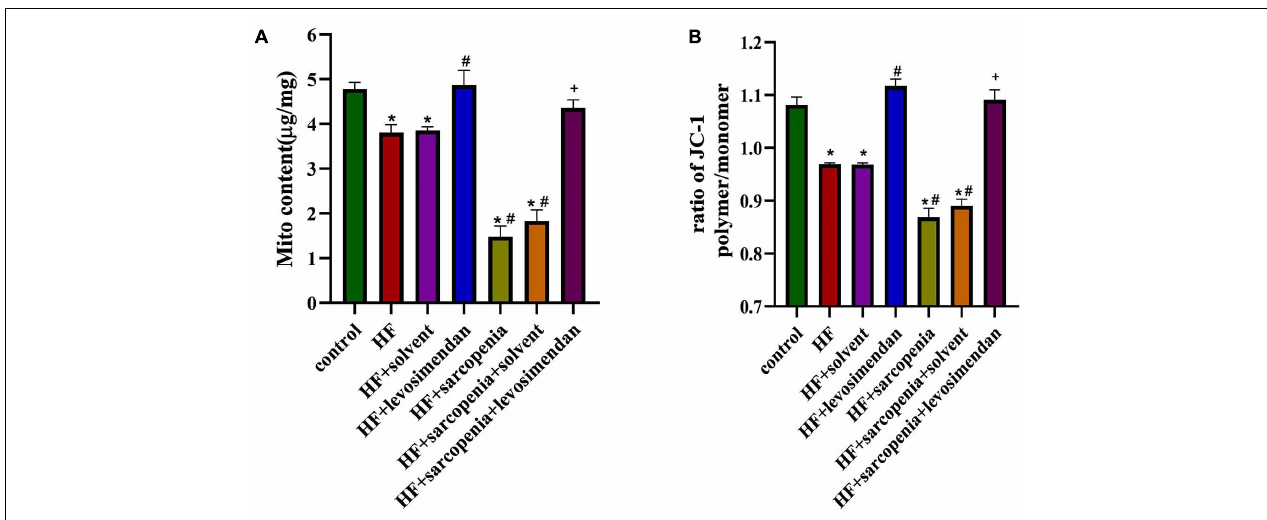
FIGURE 5 | Levosimendan improves mitochondrial function of skeletal muscle. (A) Mitochondrial content ( µ g/mg). (B) Determination of (cid:49) ψ m using the JC-1 probe. The ratio of polymer to monomer fluorescence intensity was calculated. N = 5–12. * P < 0.05 vs. control, # P < 0.05 vs. HF, + P < 0.05 vs. HF + sarcopenia.